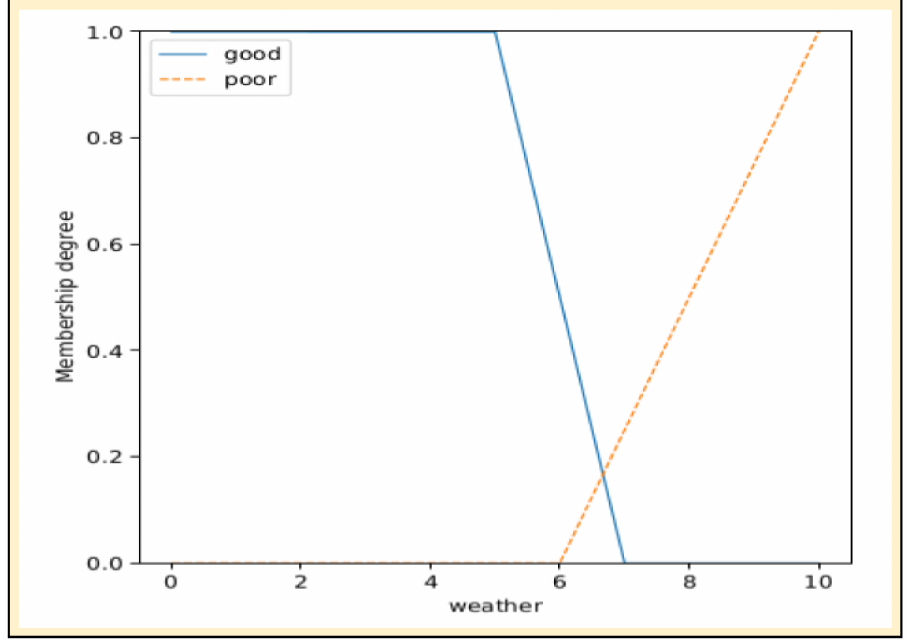
Figure 8. The fuzzy representation of weather. Brightness is a value that ranges from “ Dark ” to “ Overbrightness ” with numerical associations in the range of [0:10] (see the fuzzy representation of brightness in Figure 9). It has a fuzziness equivalent of [“ Dark ”, “ Good ”, “ Bright ”], with an optimal brightness achieved at 5. The lowest values correspond to Darkness and the highest to Overbrightness, both having a negative effect on perception. The membership values for Brightness are split between three functions: “Dark”, “Good”, and “Bright”. The lower the brightness, the higher the “Dark” function membership value is, while too bright an environment is considered as too “Bright”, meaning